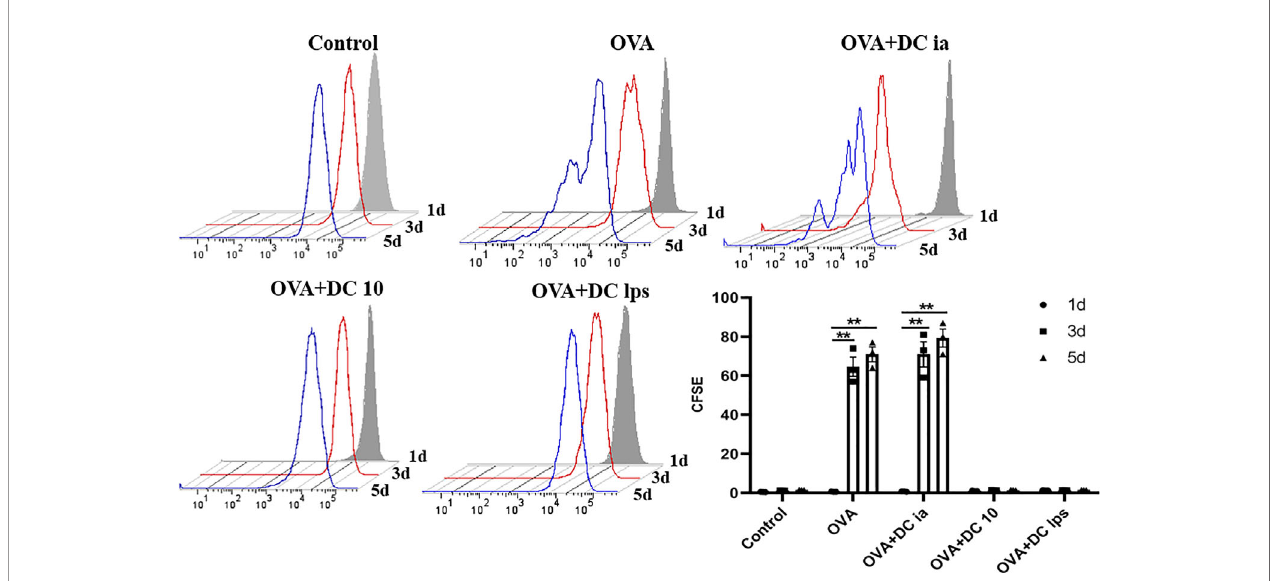
FIGURE 5 | Adoptive transfer of DClps inhibited pulmonary memory CD4 + T cell proliferation. Pulmonary memory CD4 + CD44 + T cells were sorted by FCM and then stained by CFSE. After MLR, the proliferation activity of memory CD4 + CD44 + T cells was determined by FCM. The columns and error bars represent the mean and SEM. (**P < 0.01, ANOVA with Tukey ’ s post hoc analysis). The same experiment was repeated three times with similar results (n = 5 in each